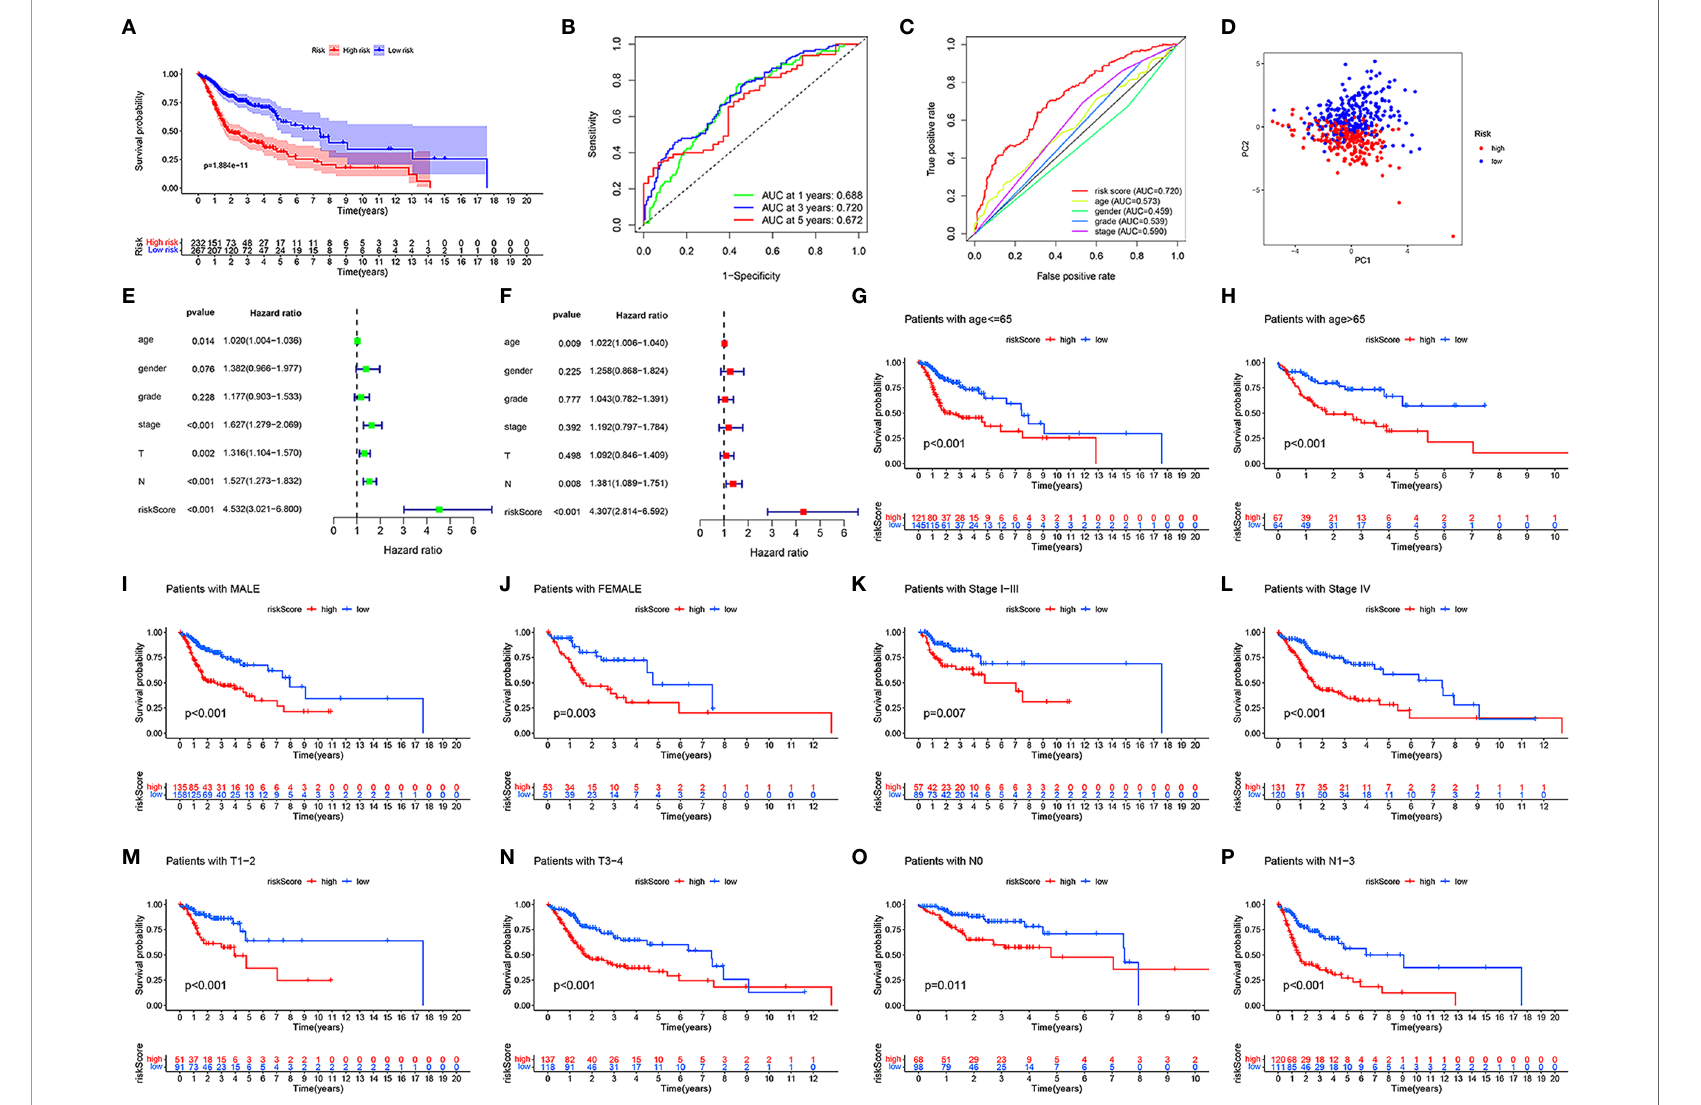
FIGURE 4 | Validation in different clinical traits subgroups. In all HNSCC samples, the Kaplan-Meier survival curve demonstrating the clinical outcome differences between the high- and low-risk groups (A) . The ROC curves for 1-, 3-, and 5-year OS (B) , ROC curves of clinicopathological characteristics and risk score (C) for 3-year OS. PCA of all HNSCC samples (D) . Univariate and multivariate Cox regression survival analysis validated whether age, gender, grade, stage, T, N, and risk score could independently predict the clinical outcomes of patients with HNSCC (E, F) . Kaplan-Meier curves showing the differences in prognosis between the high- and low- risk groups in different clinical subgroups, including ≤ 65 (G) , >65 (H) , male (I) , female (J) , stage I-III (K) , stage IV (L) , T1-2 (M) , T3-4 (N) , N0 (O) , and N1-3 (P)